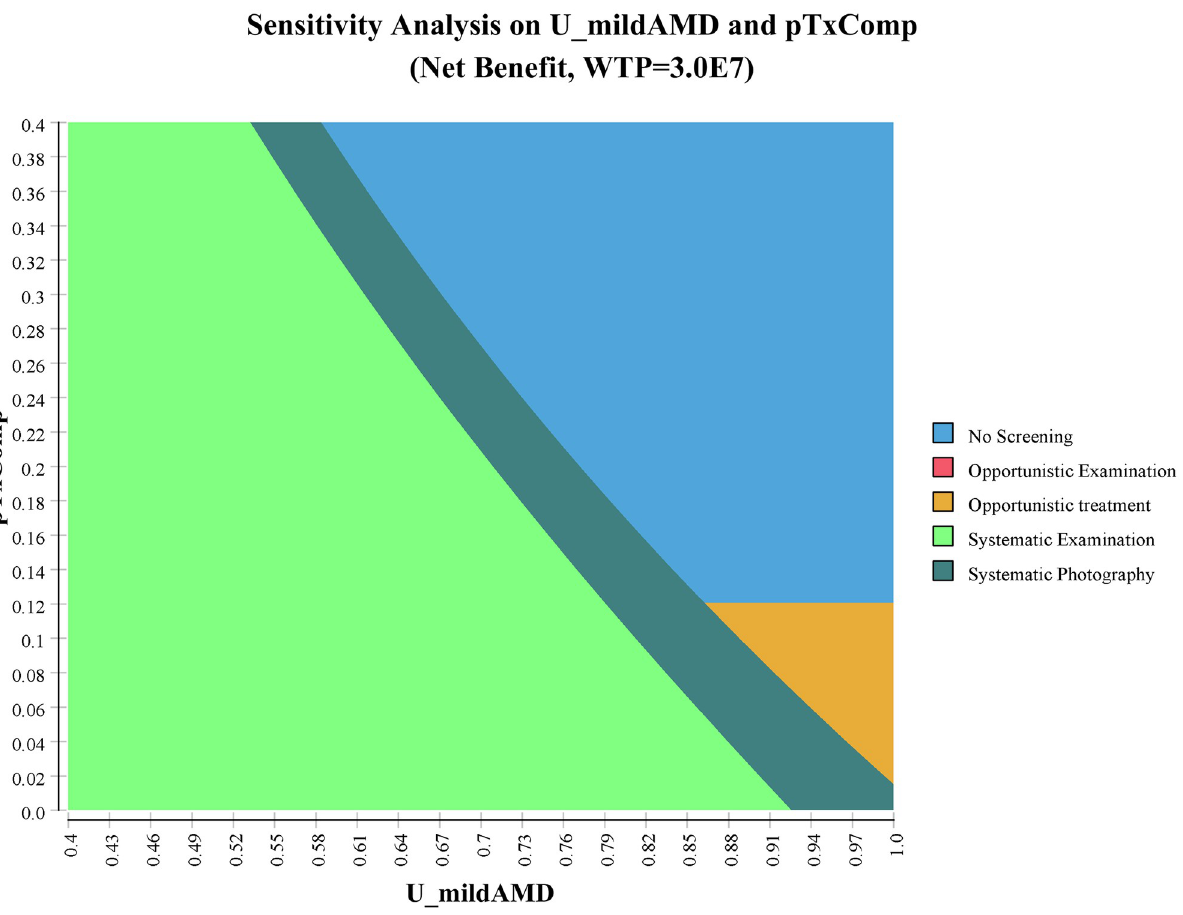
Fig 3. Two-way sensitivity analysis simultaneously varying the utility weight of mild age-related macular degeneration and the complication rate of